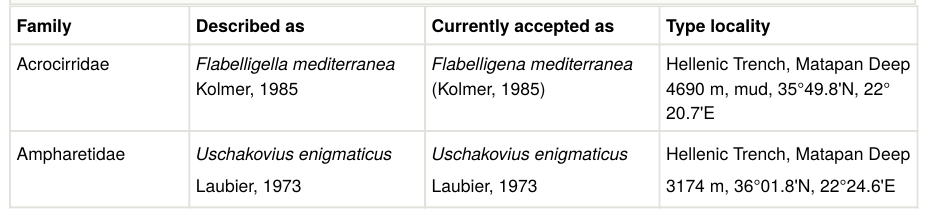
Species originally described from Greek waters (i.e. the Exclusive Economic Zone as de fi ned by ma